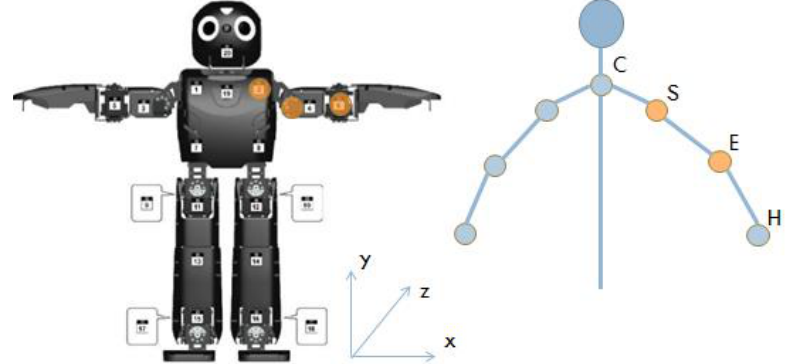
Figure 3. A diagram of OP2 on the left, in comparison to a person on the right, where C stands for center, S for shoulder, E for elbow, and H for hand. OP2 is capable of reproducing the 2 degrees of freedom (DoF) found in the human shoulder and the 1 DoF in a human elbow, but cannot reproduce hand or wrist movement.